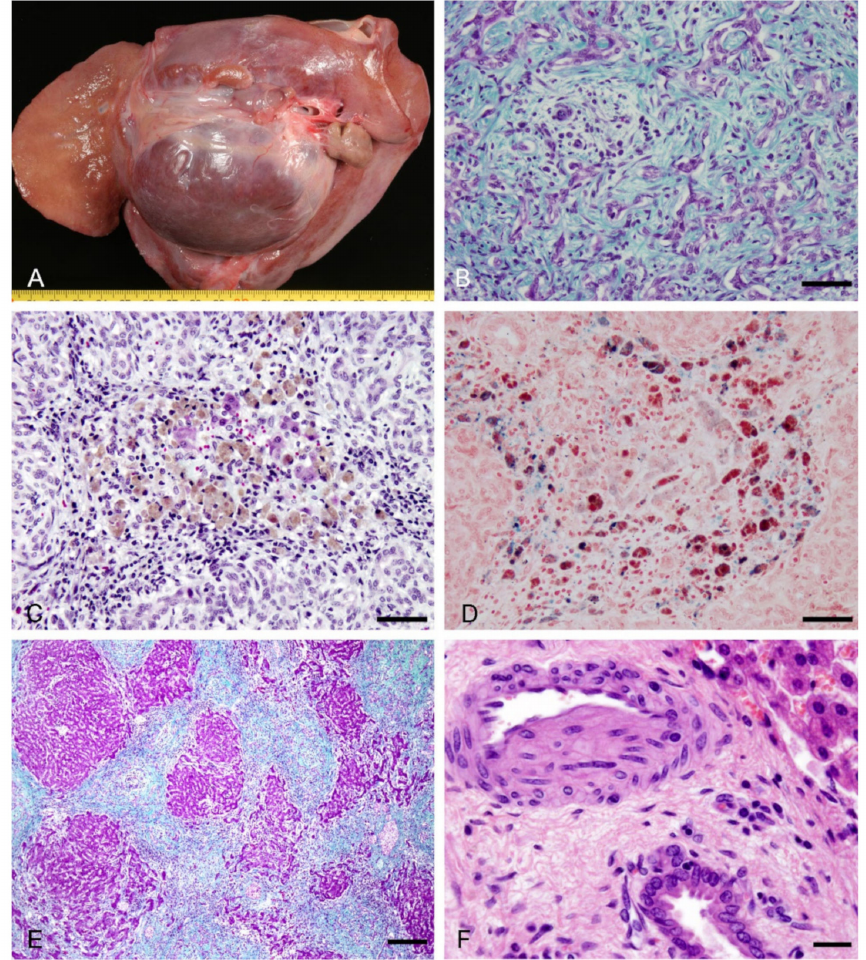
Figure 2. Chronic lesions observed in naturally acquired cases of FE in sheep. ( A ) Marked atrophy in the hepatic left lobe and a large nodule in the hepatic visceral surface. ( B ) Hepatic lobular areas are replaced by proliferated bile ductules (atypical ductular reaction) and fibrous tissue. Masson-Goldner trichome stain. Bar, 50 µ m. ( C ) Numerous lymphocytes and pigmented macrophages were seen in the fibrous tissue in association with remnants of hepatic lobes. Masson-Goldner trichome stain. Bar, 50 µ m. ( D ) Macrophages were positively red stained for lipofuscin (AFIP stain) that coexisted in some cells with hemosiderin. Perls’ Prussian blue stain. Bar, 50 µ m. ( E ) Jigsaw pattern characteristic of the biliary cirrhosis. Masson-Goldner trichome stain. Bar, 200 µ m. ( F ) Eccentric myointimal proliferation in a hepatic arteriole adjacent to the bile duct. HE. Bar, 20 µ